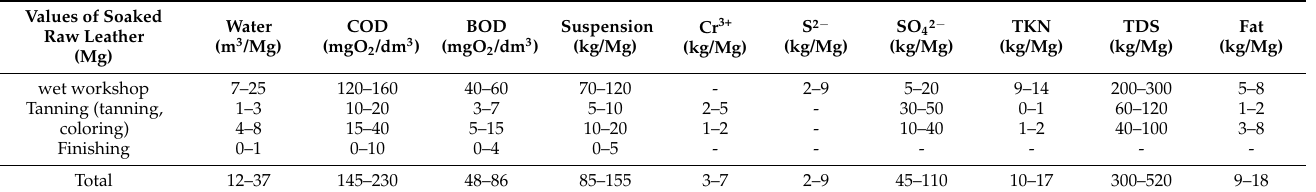
Table 4. Values set by the Committee on the Environment of the International Union of Leather Engineers and